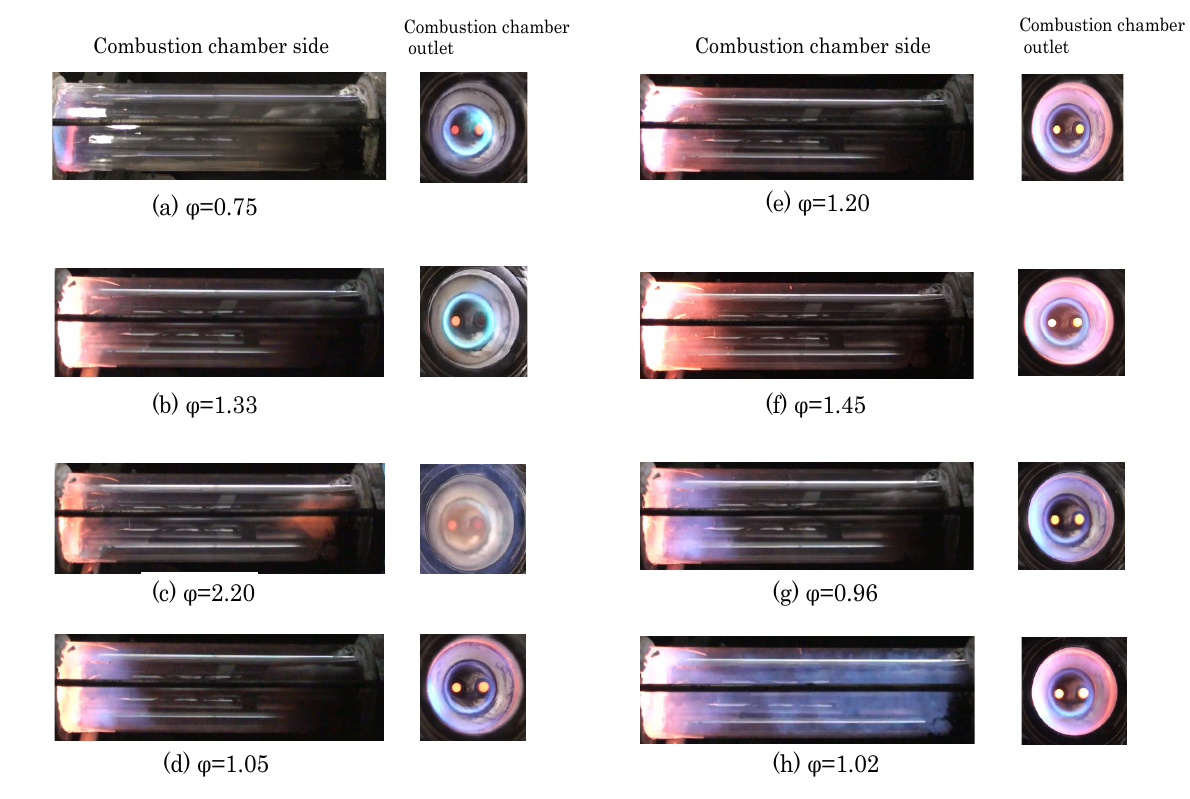
Figure 9. Direct photo of these typical flames.